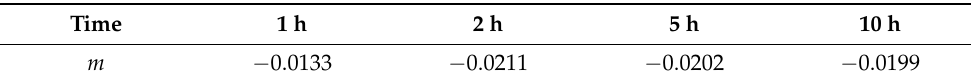
Table 5. The strain rate sensitivity value at different aging